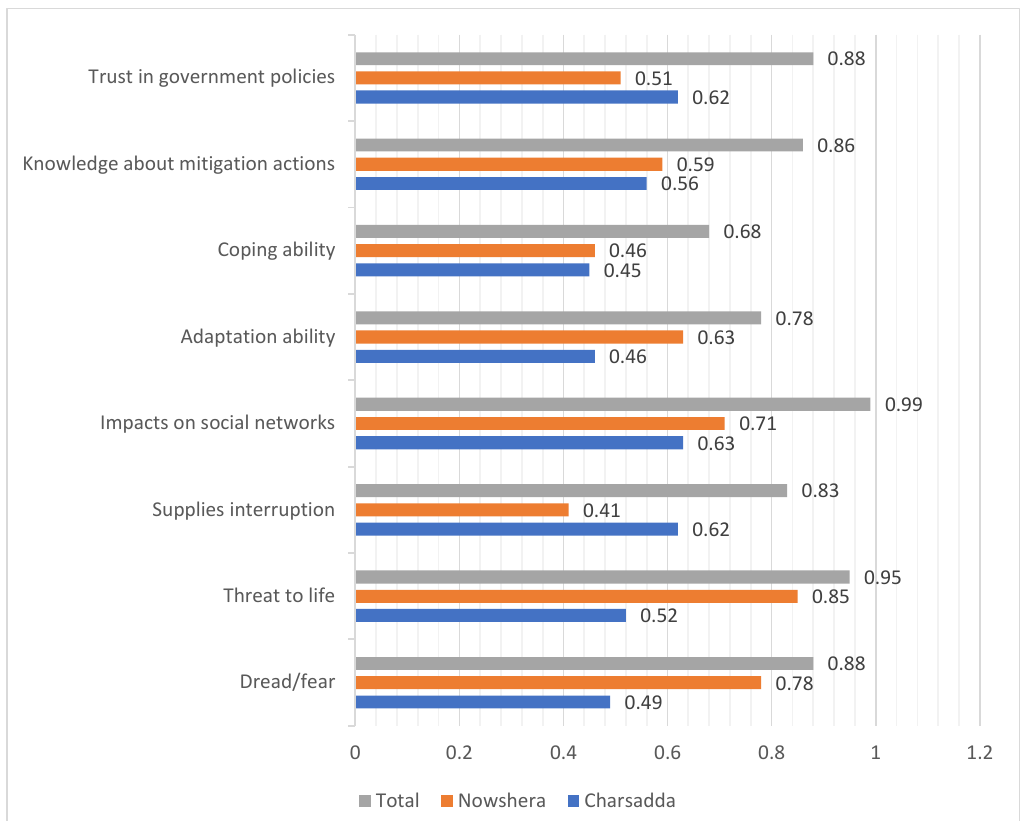
Figure 4. Other related uncertainties/adaptabilities.